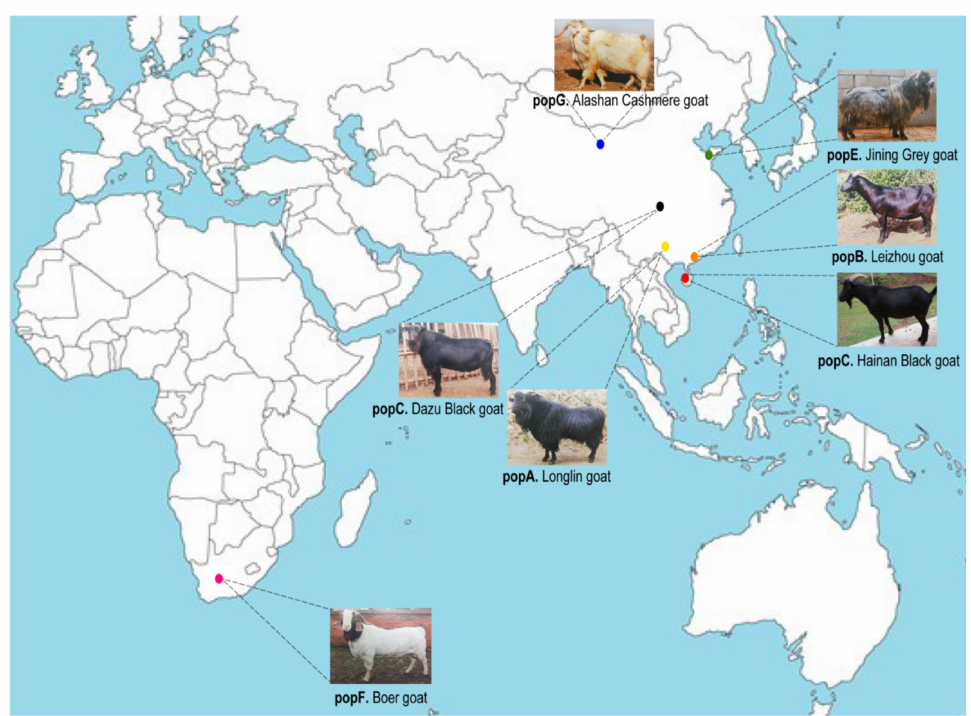
Figure 1. Summary of all seven goat breeds included in this study. Geographic map indicating the distribution of the goats included in this study. Goat photographs reprinted from Ref. [3] except Hainan Black goat photograph was taken by Wencan Zhang.